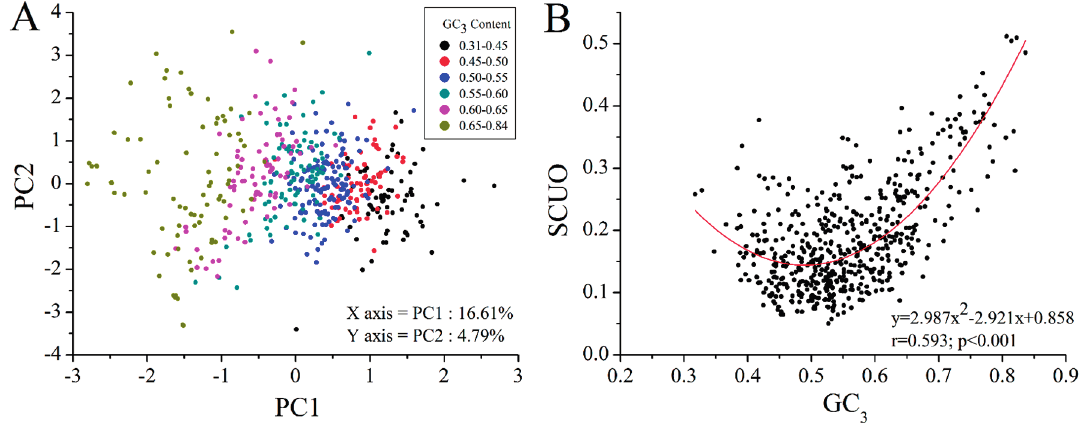
Figure 5. Correlation between GC 3 content and codon usage bias (RSCU and SCUO) in M. amblycephala . ( A ) The PCA analysis of RSCU of 59 codons from 646 ORFs on the primary and secondary axes (accounting for 16.61% and 4.79% of the total variations, respectively) and demonstration by 6 GC 3 levels; ( B ) SCUO versus GC 3 plot with polynomial